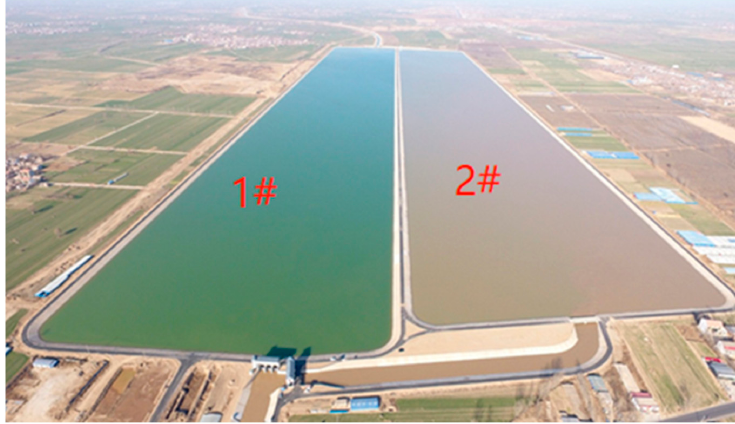
Figure 2. Arrangement of sedimentation basin.